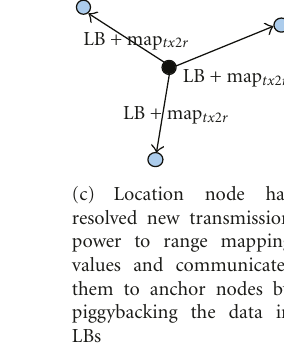
Figure 21: Distributed localization.